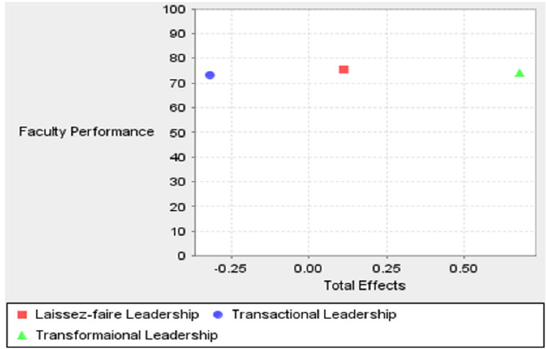
Fig 9. Importance-Performance Map (unstandardized)